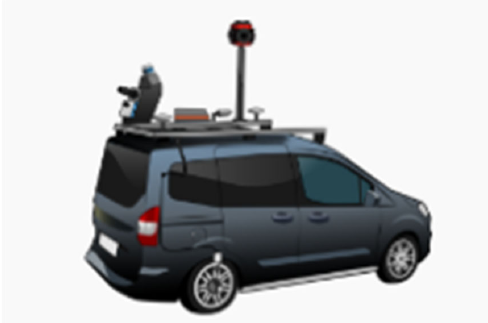
Figure 2. Mobile LiDAR System (AnkaGeo, 2023)